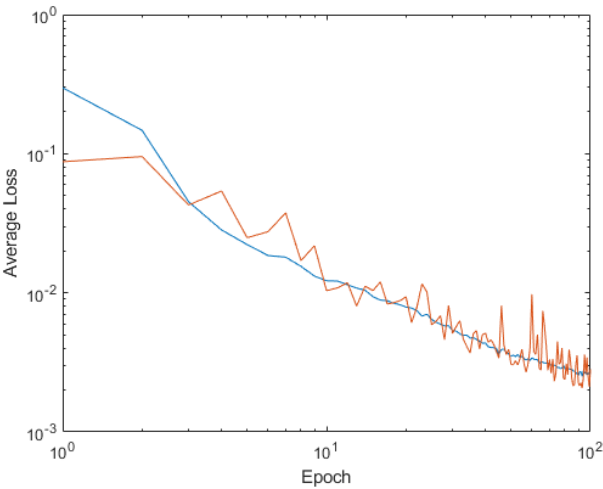
Figure 15. Average loss on training patterns in blue and validation patterns in orange for Dynamic alpha and Dynamic drop-out mixed together SGD of Ackley function.